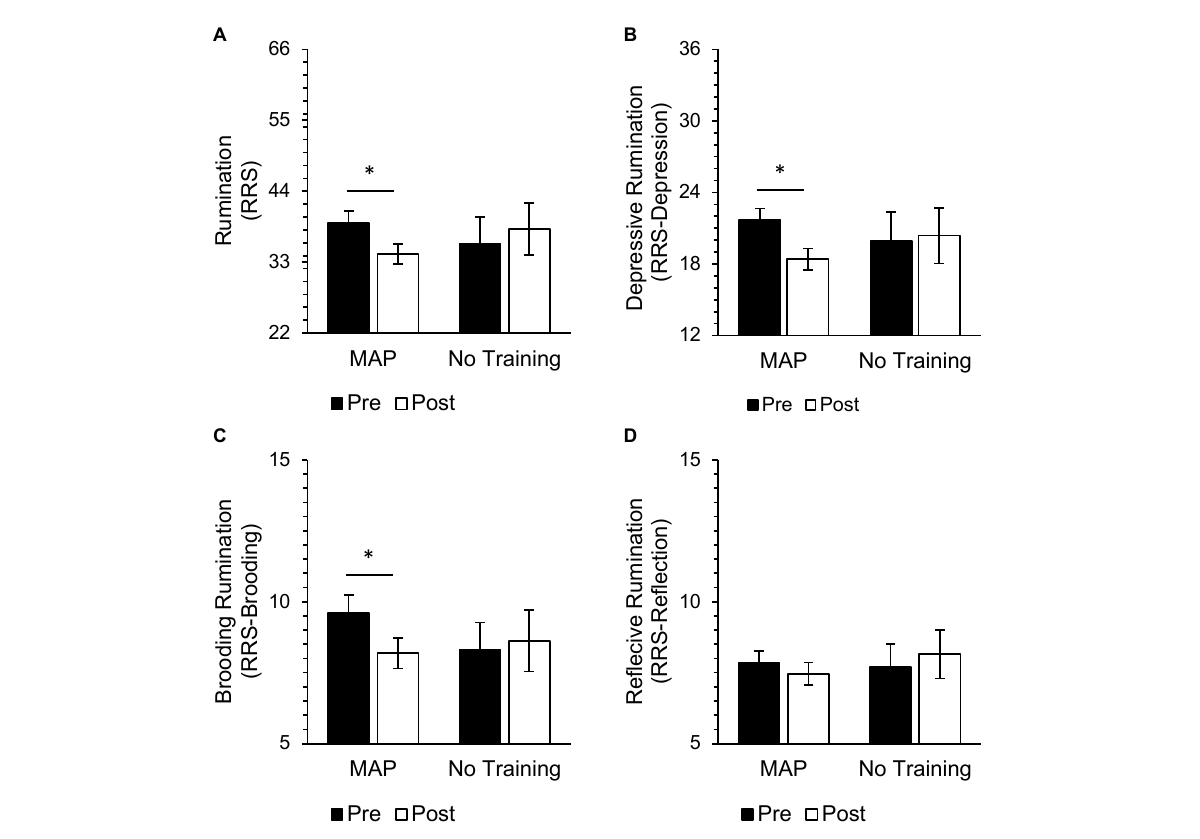
FIGURE4 In the MAP group, post-intervention scores were significantly improved from pre-intervention scores on measures of rumination [ (A) RRS], including depressive rumination [ (B) RRS-Depression] and brooding [ (C) RRS-Brooding], but not reflective rumination [ (D) RRS-Reflection]. There were no significant differences between pre-intervention and post-intervention scores on these same measures in the No Training group. There were also no significant differences between groups at either timepoint. Asterisks indicate significant adjusted p -values. Total scores on the RRS range from 22 to 88, RRS-Depression subscores range from 12 to 48, RRS-Brooding subscores range from 5 to 20, and RRS-Reflection subscores range from 5 to 20.